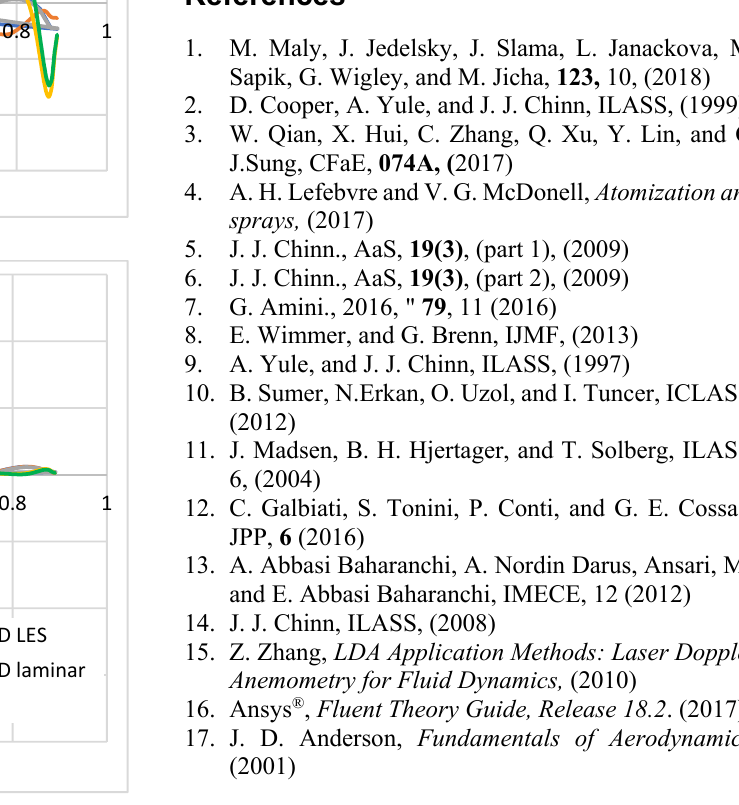
Fig. 10. Axial velocity